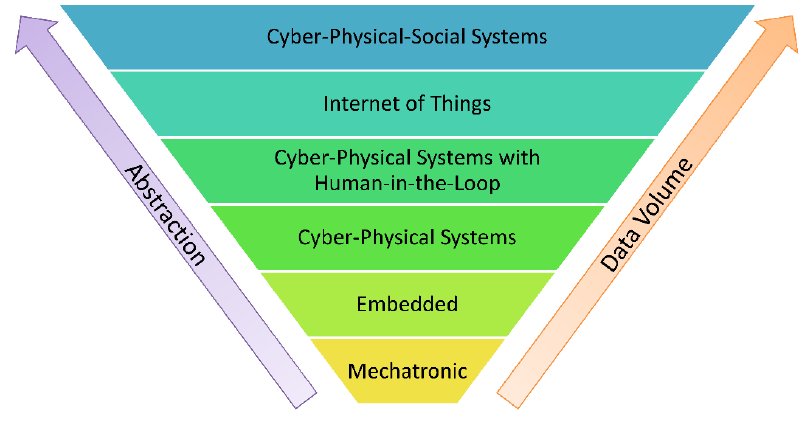
Figure 2. Evolution of CPSS.